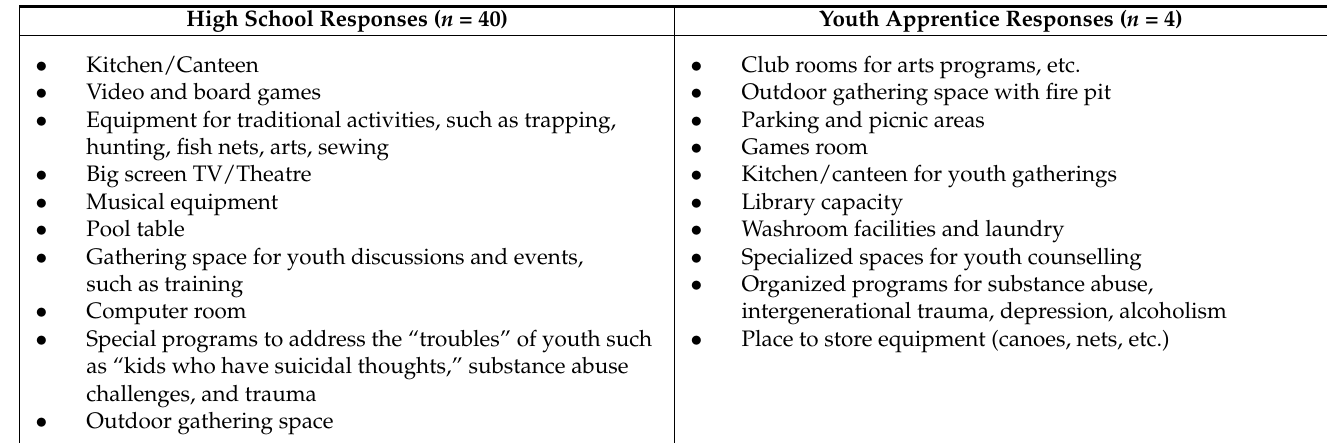
Table 2. Youth-Identified Needs in Kasabonika Lake By